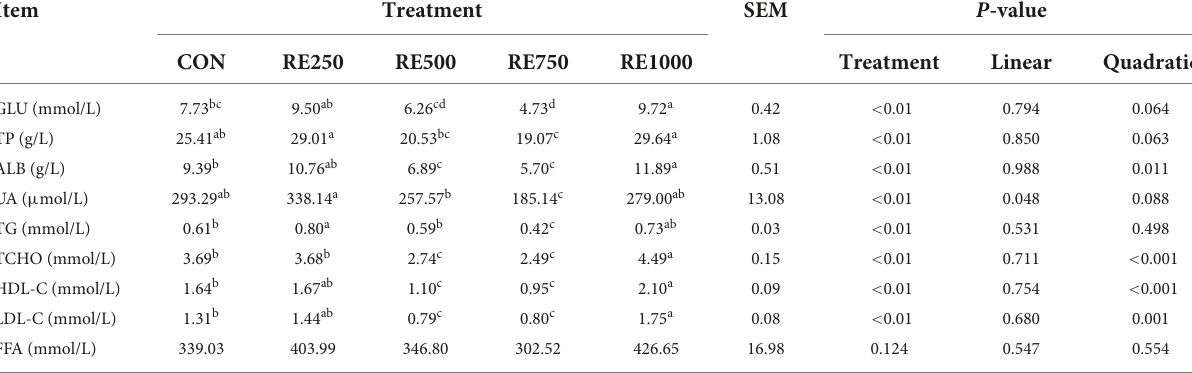
TABLE 4 Effects of rosemary extract on serum biochemical indexes of broilers 1 .